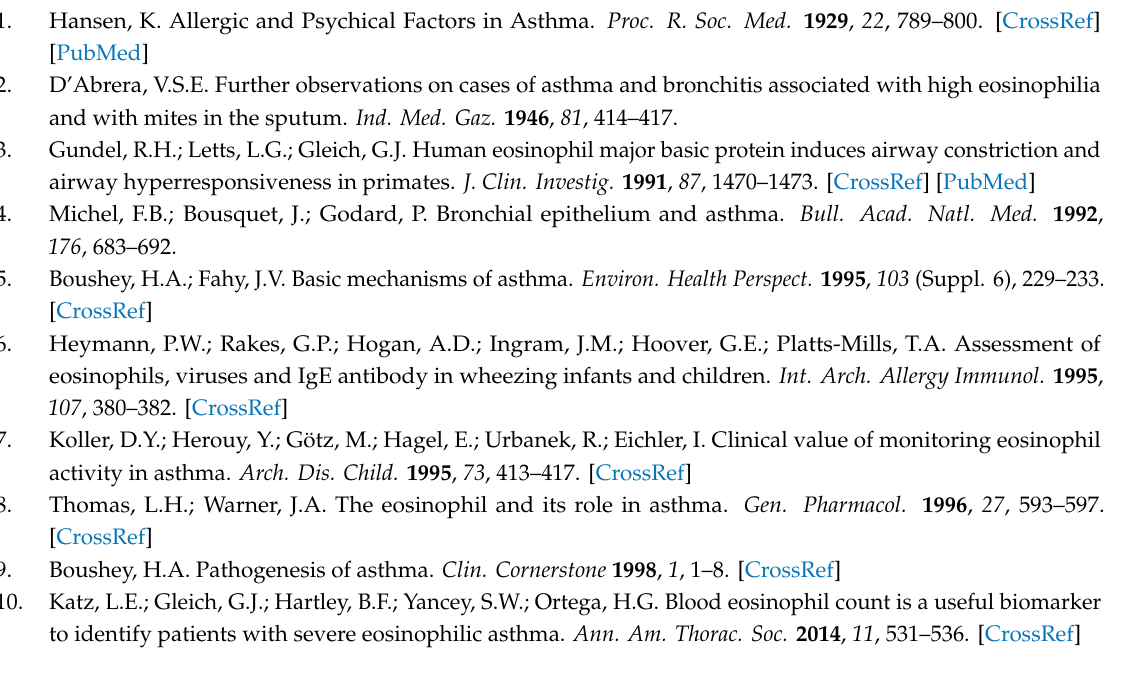
Figure S1: Colonization levels in the lungs of Balb / c and DdblGATA-1 mice following infection with Bb and